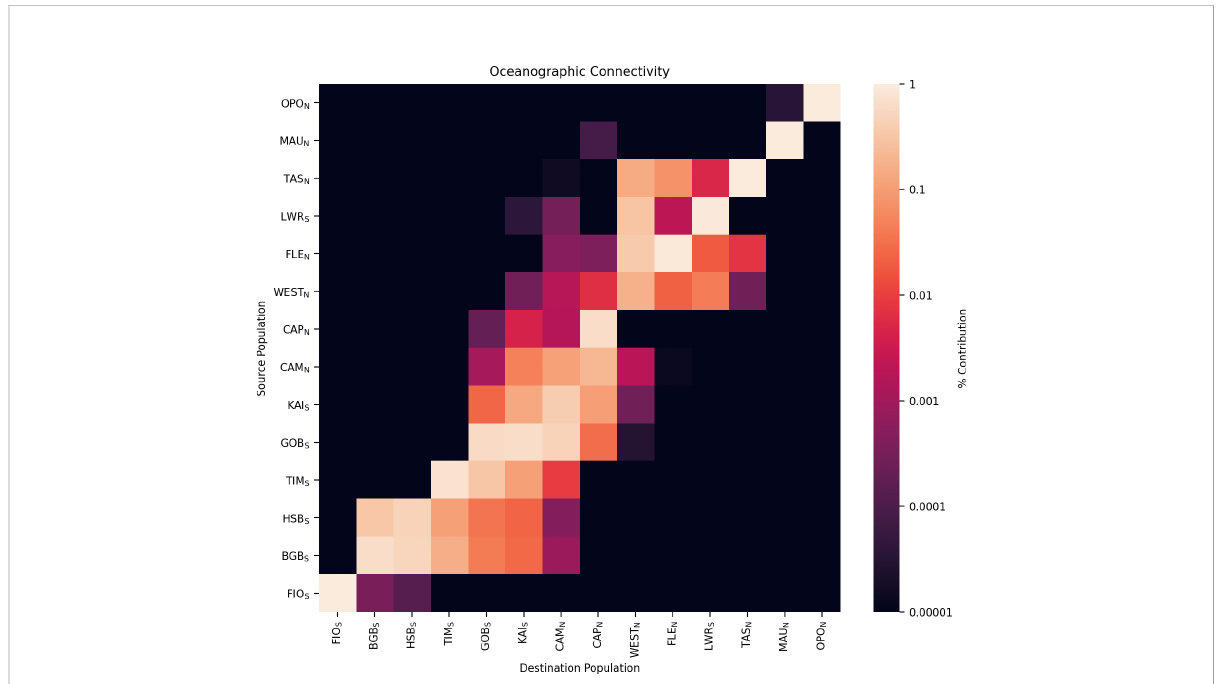
FIGURE 4 Connectivity matrix for 14 sites sampled for microsatellite loci. Data are presented as the proportion of total particles that settle in each destination populations (columns) that originate from each source population (rows). Populations are ordered to highlight clustering structure, and are shown roughly south to north. Self-recruitment can be seen along the diagonal. Subscripts to population names indicate clusters as assigned by STRUCTURE and Geneland analyses.